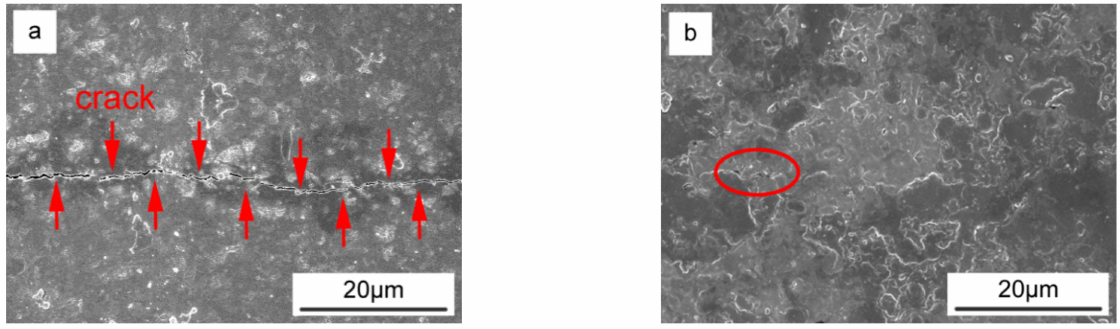
Figure 3. Repair properties of Al 2 O 3 /TiC/TiB 2 ceramic. ( a ) prefabricated crack ( b ) healed